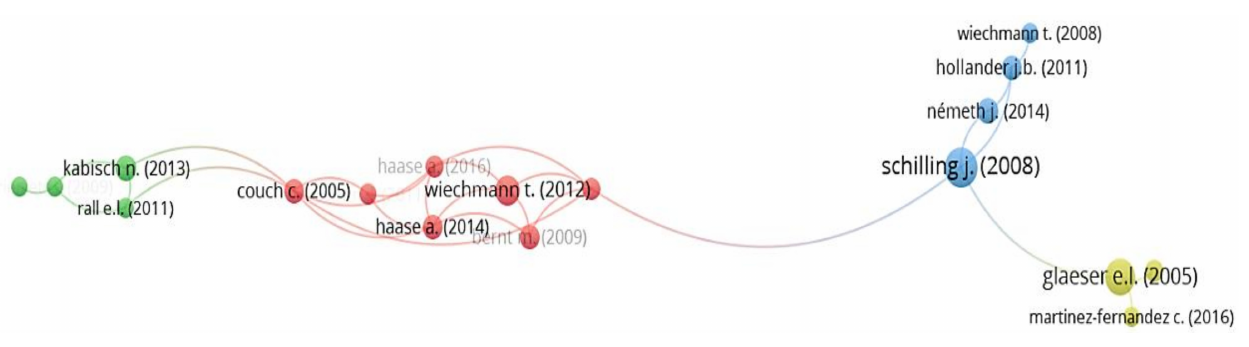
Figure 6. Scientific mapping of article impact in SCT-related